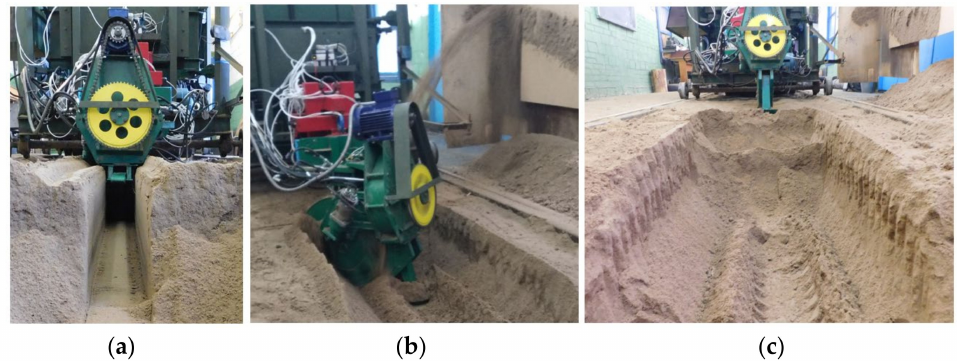
Figure 3. Experimental studies on the physical model of the operating equipment: ( a ) a profile of the developed trench; ( b ) the operating process when constructing a wide excavation; ( c ) a profile of a wide excavation during one or two